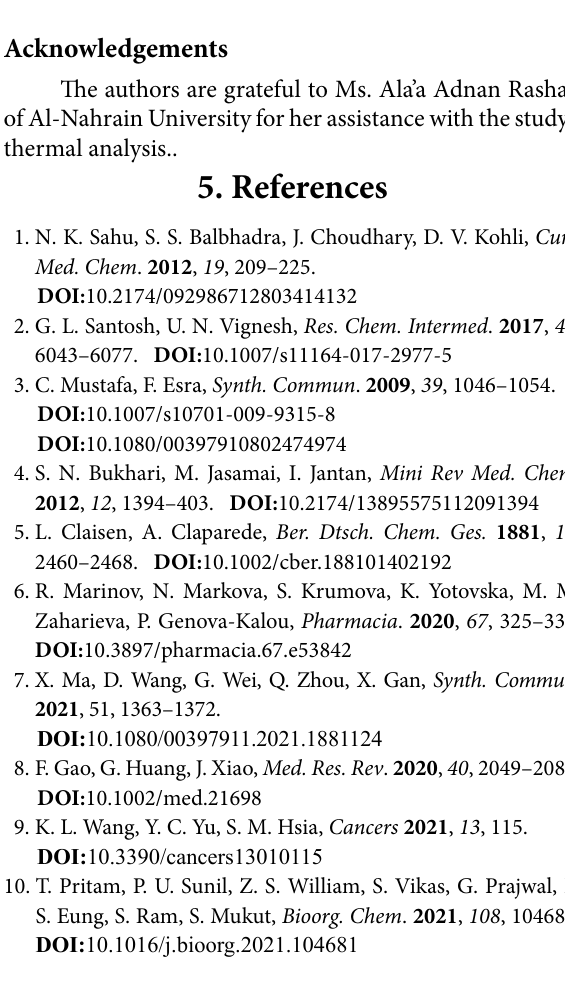
Figure 7: Polarized optical micrographs for: (a) compound B5 (SC at 174.25 °C); (b) compound B6 (N, at 68.62 °C); (c) compound B7 (N, mosaic at 103.91 °C), (d) compound B8 (SA, at 106.95 °C); (e) compound B9 (N, Schlieren, at 132.27 °C); (f) compound B10 (N, mosaic at 164.30